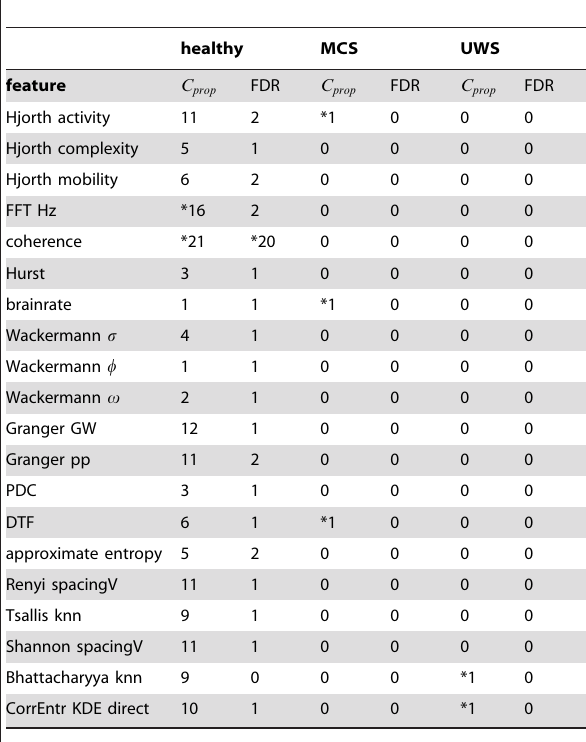
Table 4. Numbers of above-chance accuracies in the SVM